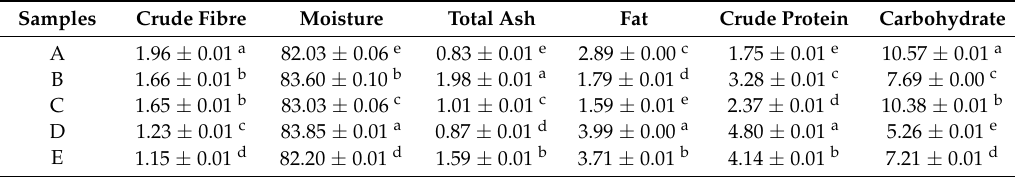
Table 2. Proximate composition of carrot-cucumber juice (%).